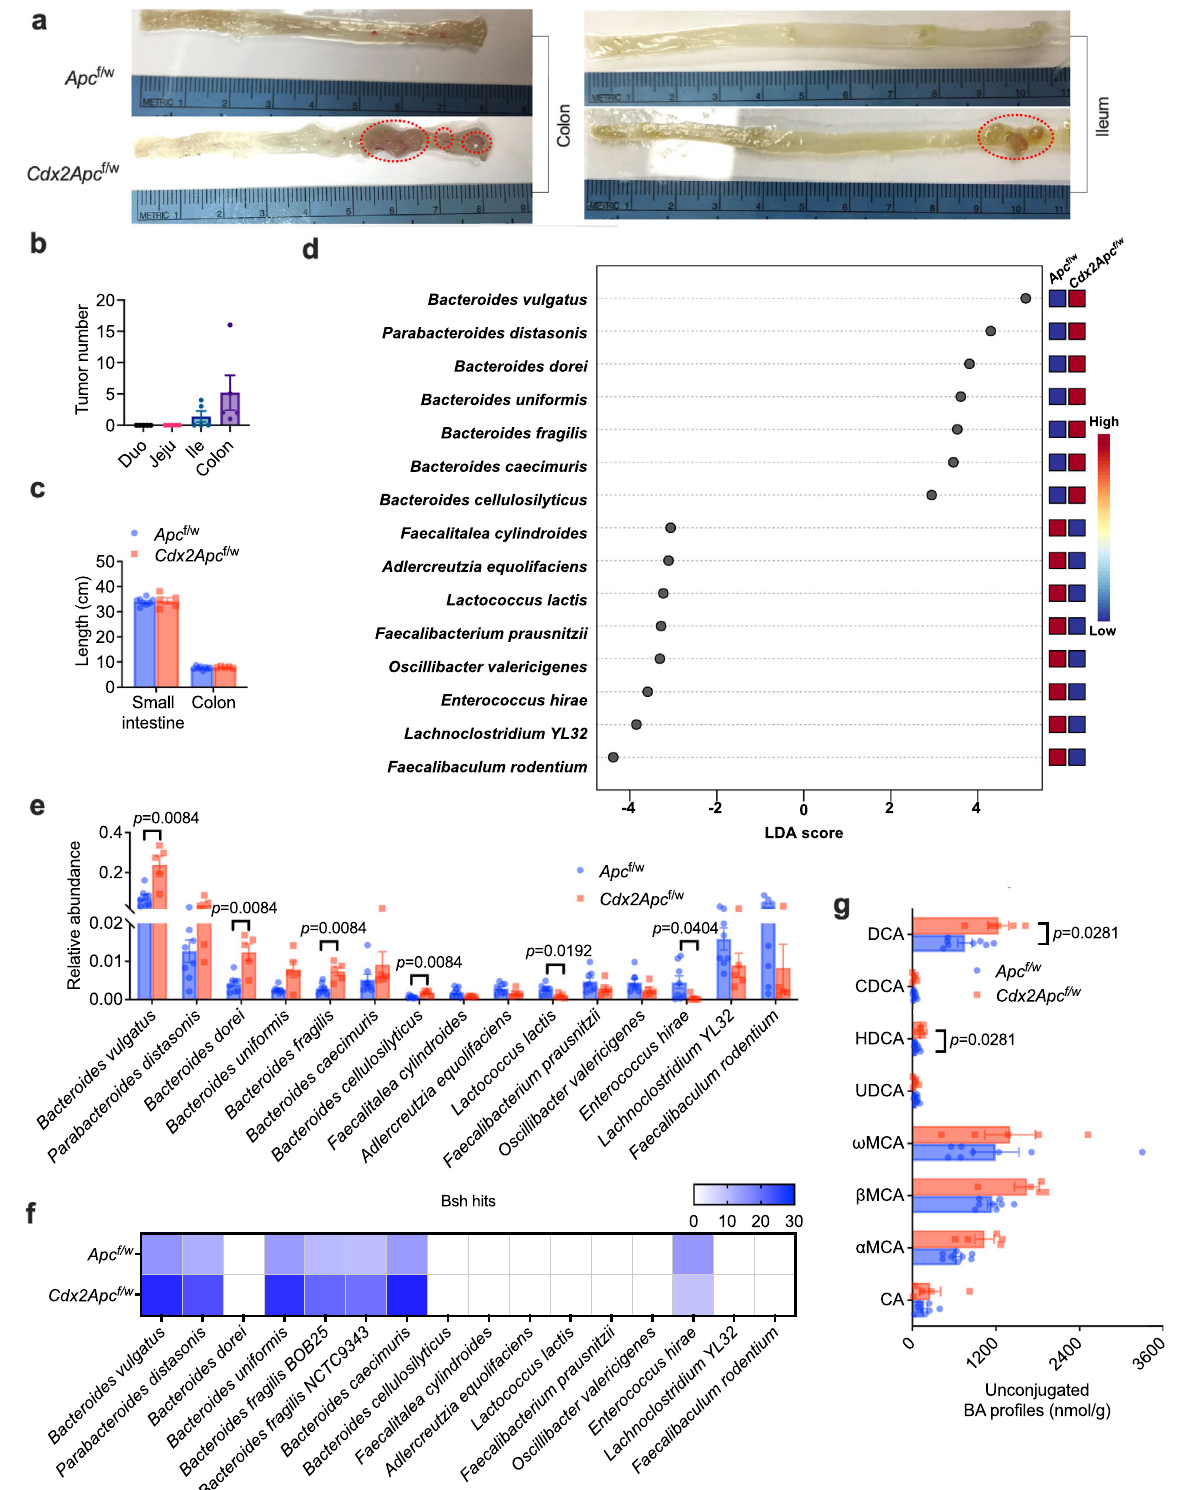
Fig.2|BSH-producing Bacteroides speciesareenrichedinaCRCmousemodel. a – g Apc f/w and Cdx 2 Apc f/w mice were fed a HFD for 12 weeks ( n =8 mice for Apc f/w ; n =5 mice for Cdx 2 Apc f/w ). a Representative pictures of ileum and colon, revealing the tumor occurrence (in red circle). b Tumor numbers in different segments of intestine from 5 Cdx 2 Apc f/w mice, Duo: duodenum; Jeju: jejunum; Ile: Ileum. c Lengthofsmallintestineandcolon. d Top15speciesofgutmicrobiotathatledto